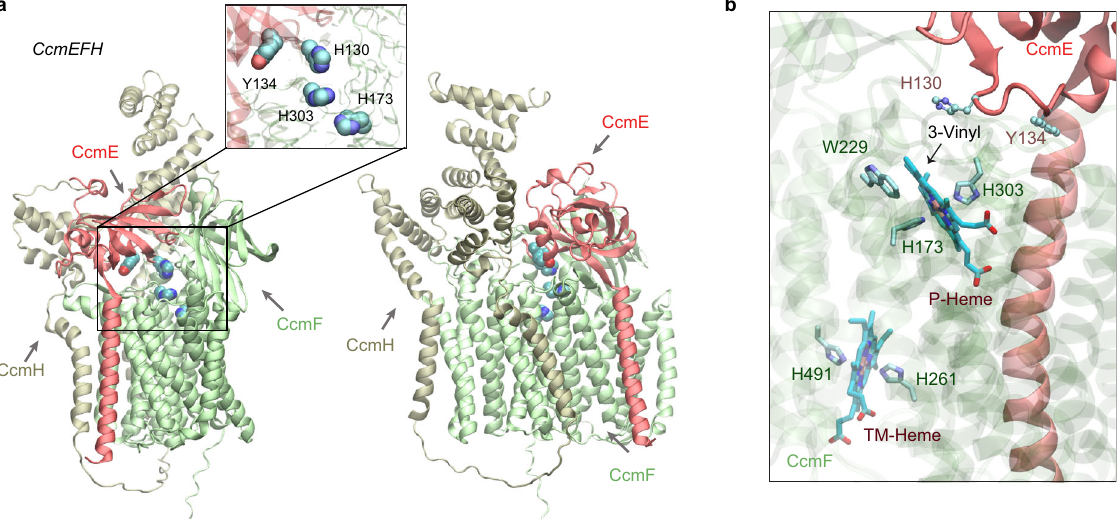
Fig. 7 Structural models of the CcmEFH complex from E. coli . a CcmE is believed to deliver heme to CcmF. Two views of a top model generated by AF2Complex are shown in the cartoon representation. The inset shows the key heme handling residues, His130 and Tyr134 of CcmE and the two histidines of CcmF. b Two heme molecules computationally placed in the expected heme-binding sites of CcmF using the model shown in ( a ). The critical heme Fe- coordinating residues, His173 (P-His1) and His303 (P-His2) for the P-heme delivered by CcmE and eventually attached to an apo-cytochrome c protein and His261 (TM-His1) and His461 (TM-His2) for the cofactor TM-heme are also shown.